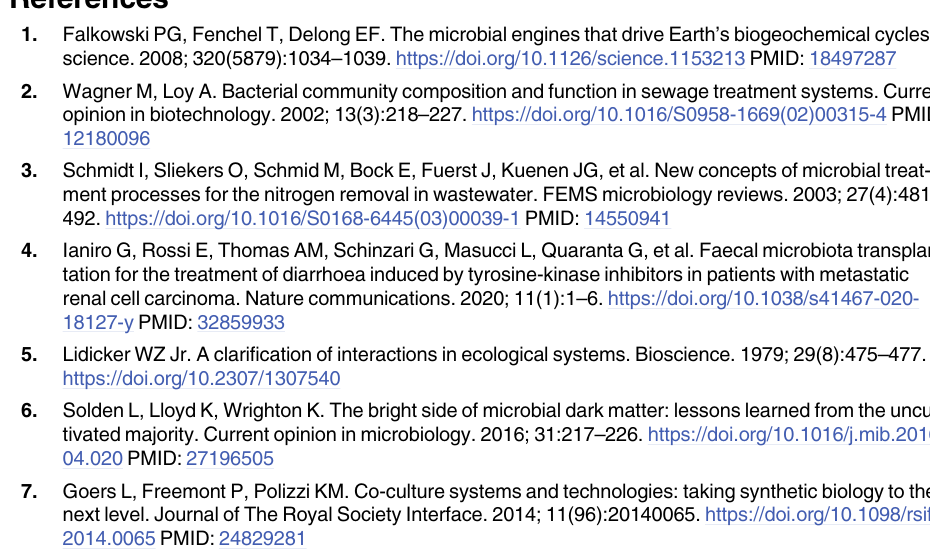
S3 Fig. This figure is analogous to Fig 2 in the main text, but with AUROC computed instead of